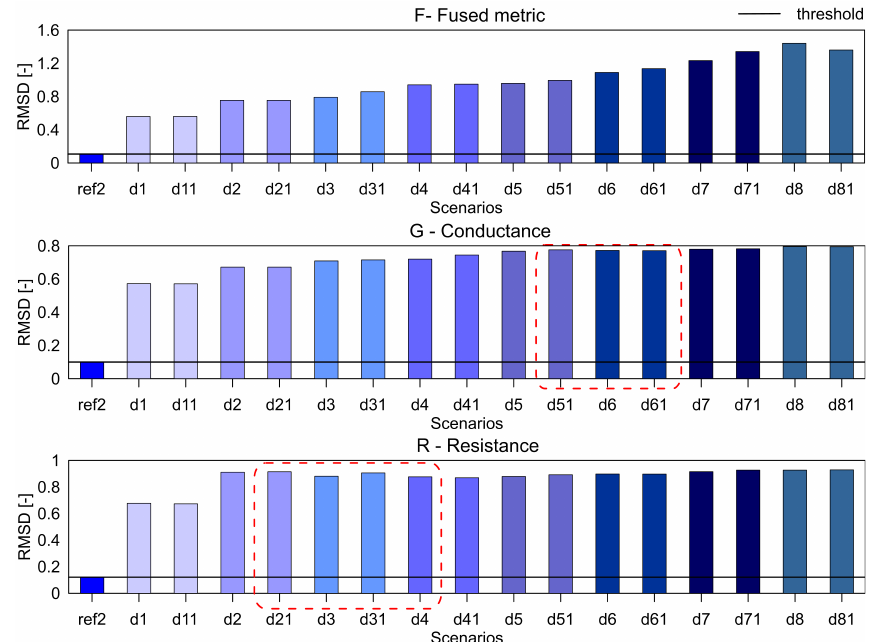
Figure 14. The RMSD index for the parameters F, G and R for the aluminium plate over the frequency range 100 kHz to 300 kHz.